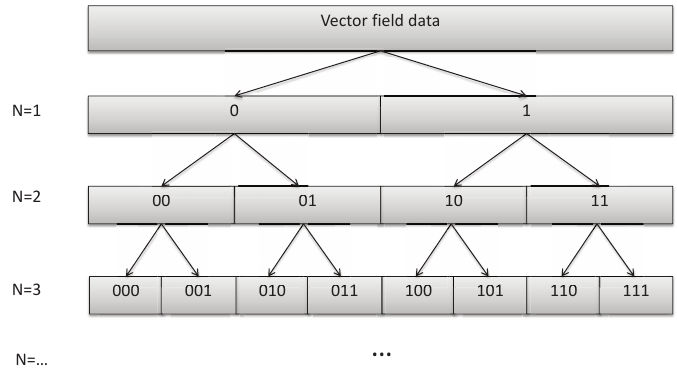
Figure 6. Special segment process. In data fluidization, data are divided and encoded according to spatial hierarchy. Data can be divided according to row, column, quartile, irregular graph and so